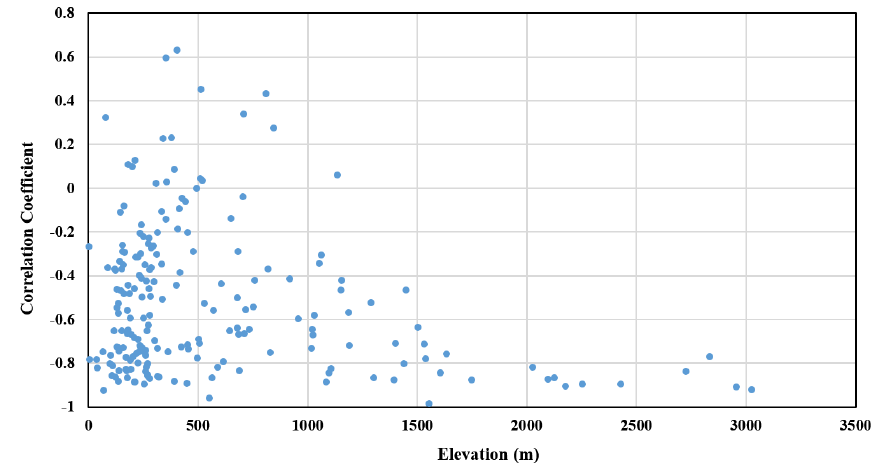
Figure 8. Scatterplot of the correlation coefficient against the elevation of the Mississippi River basin monitoring